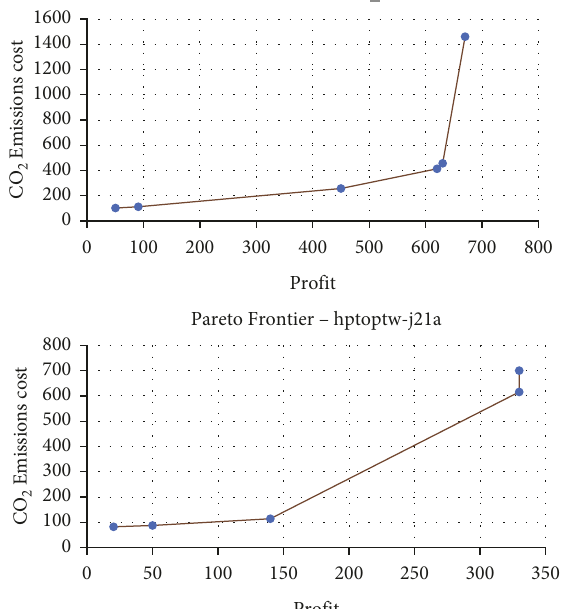
Figure 2: Pareto frontier.